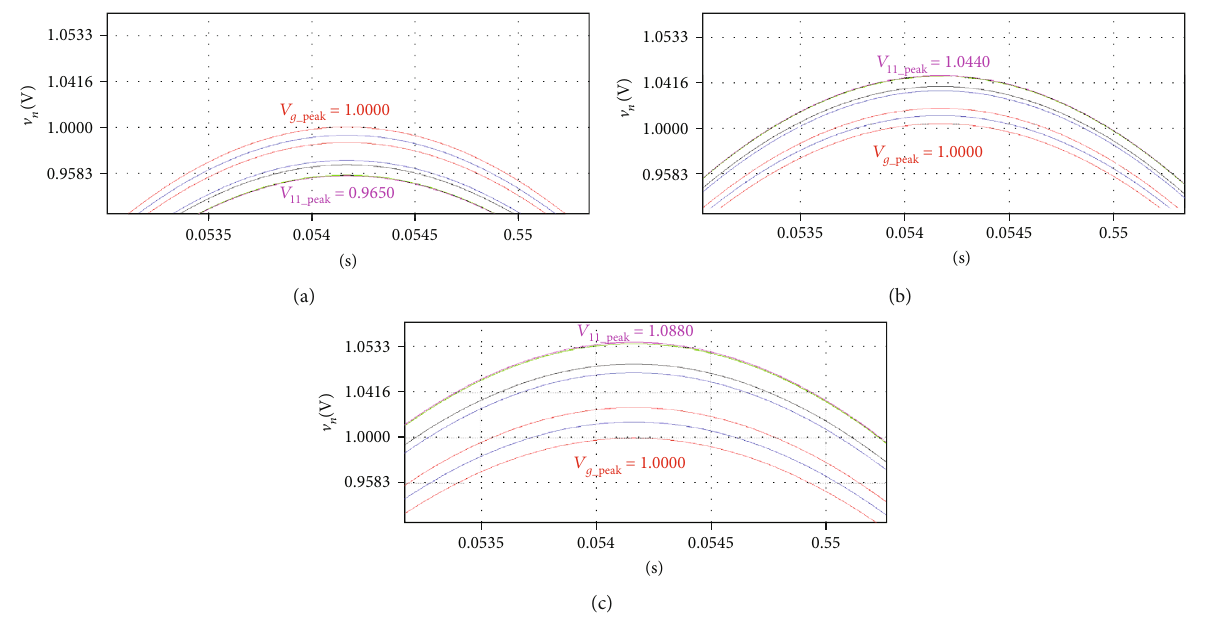
Figure 2: Voltage levels on the transformer and residences: (a) residences demanding power (-4.4 A), (b) residences injecting power (4.4A), and (c) residences injecting power (8.8